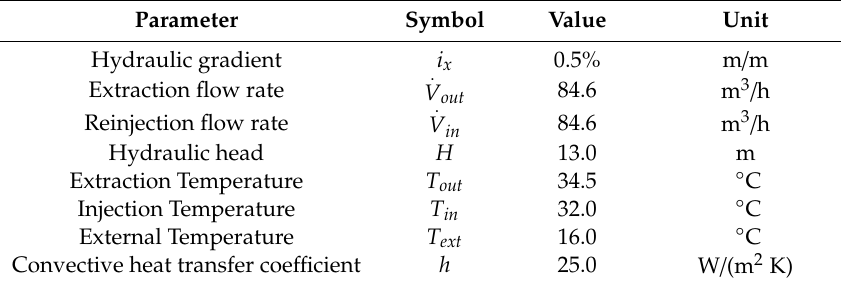
Table 4. Boundary and initial